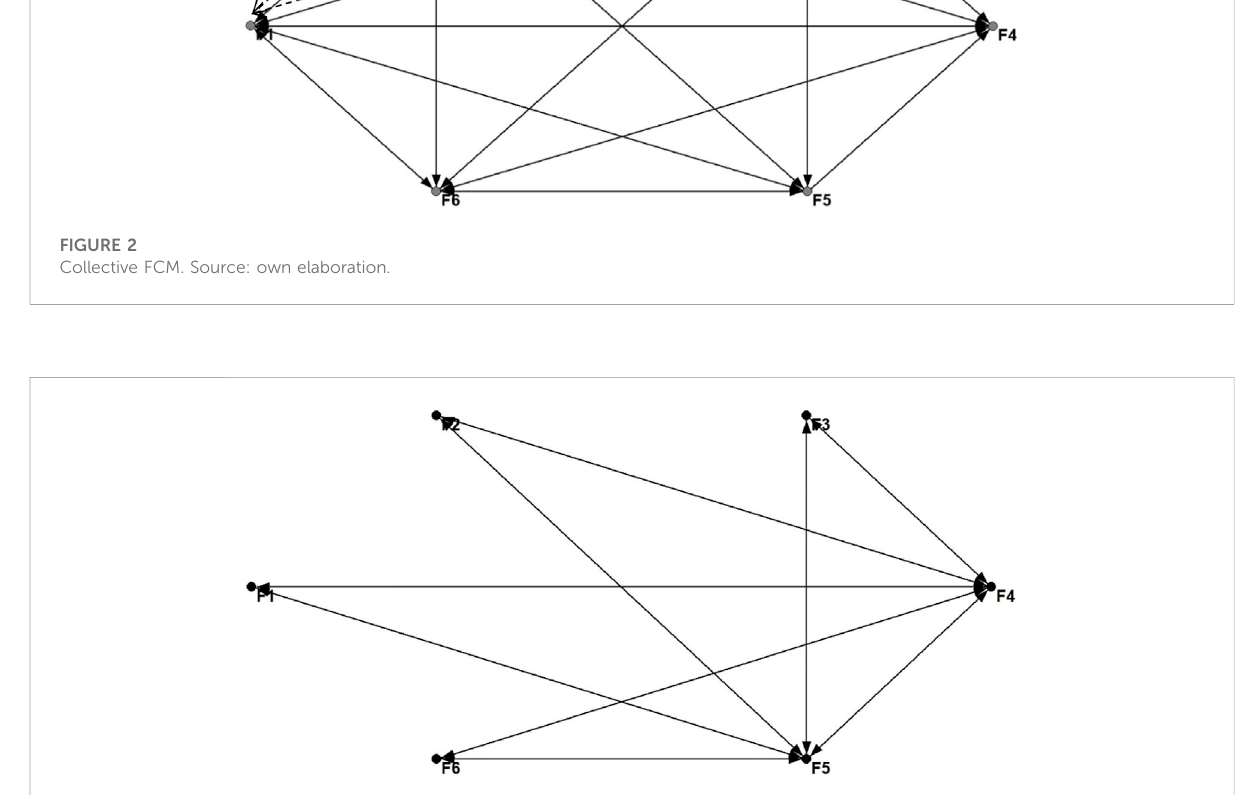
FCM for the agriculture sector, Source: own